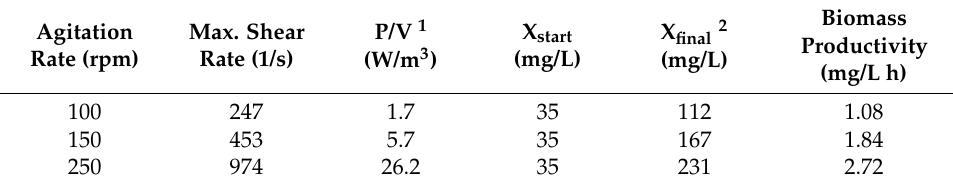
Table 1. Kinetic parameters of L. edodes fermentation at different agitation rates in a 1 L stirred tank bioreactor. Data were part of a design of experiment (DoE) with four repetitions of the center point experiment. The corresponding experimental standard deviation was below 28%.